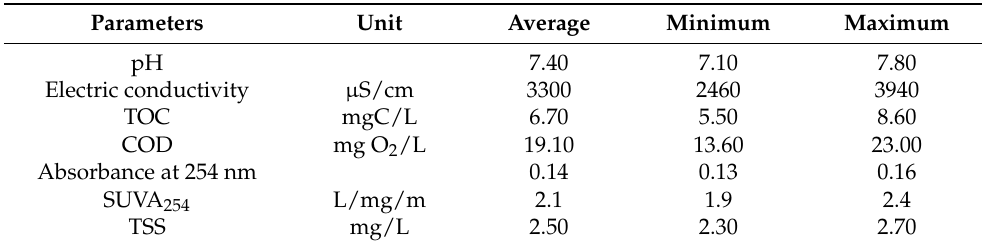
Table 1. Characteristics of real MBR effluent ( n = 5).